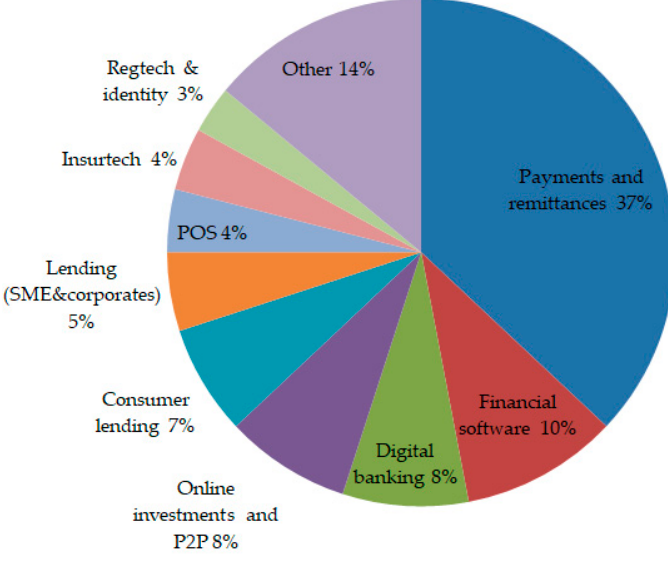
Figure 4. FinTech sector in Lithuania by activity.